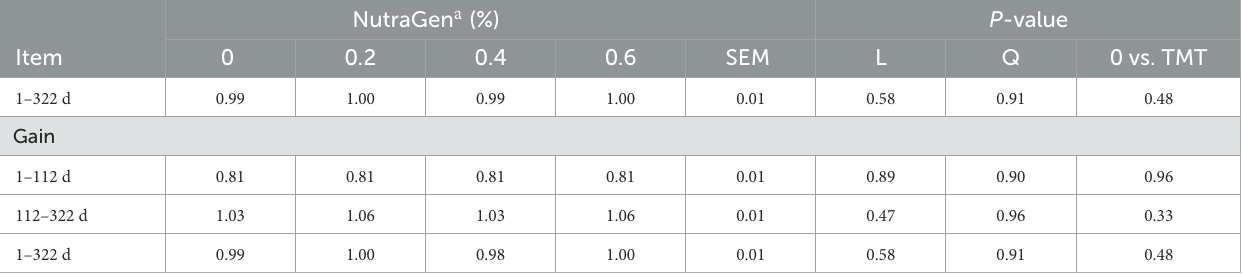
TABLE 3 Effects of feeding NutraGen supplement on carcass characteristics, liver abscess, and cattle morbidity. NutraGen a (%)